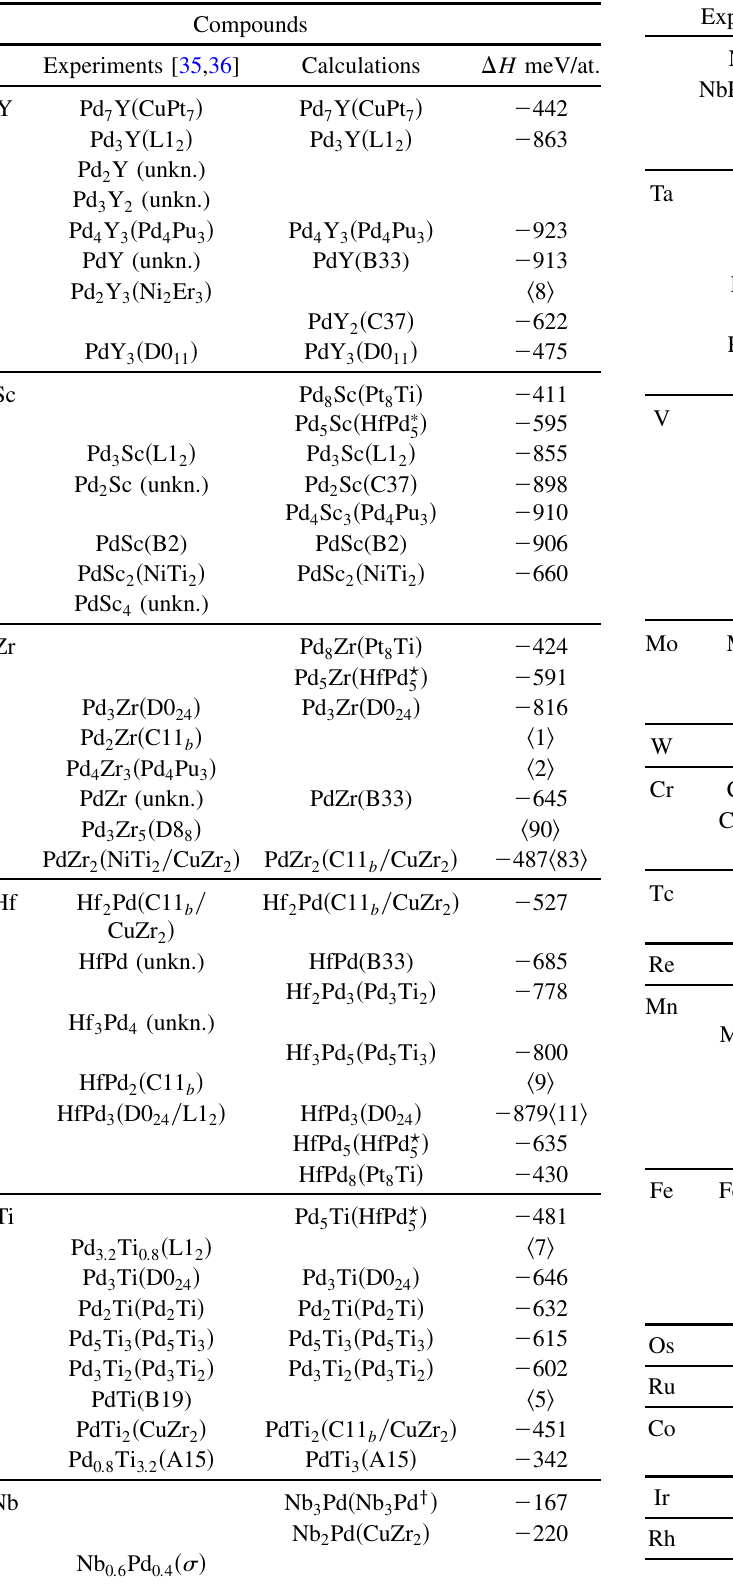
TABLE VI. Compounds in Palladium binary alloys. The term tet-fcc denotes a tetragonal distortion of stacked fcc superstruc- tures. All symbols are as in Table